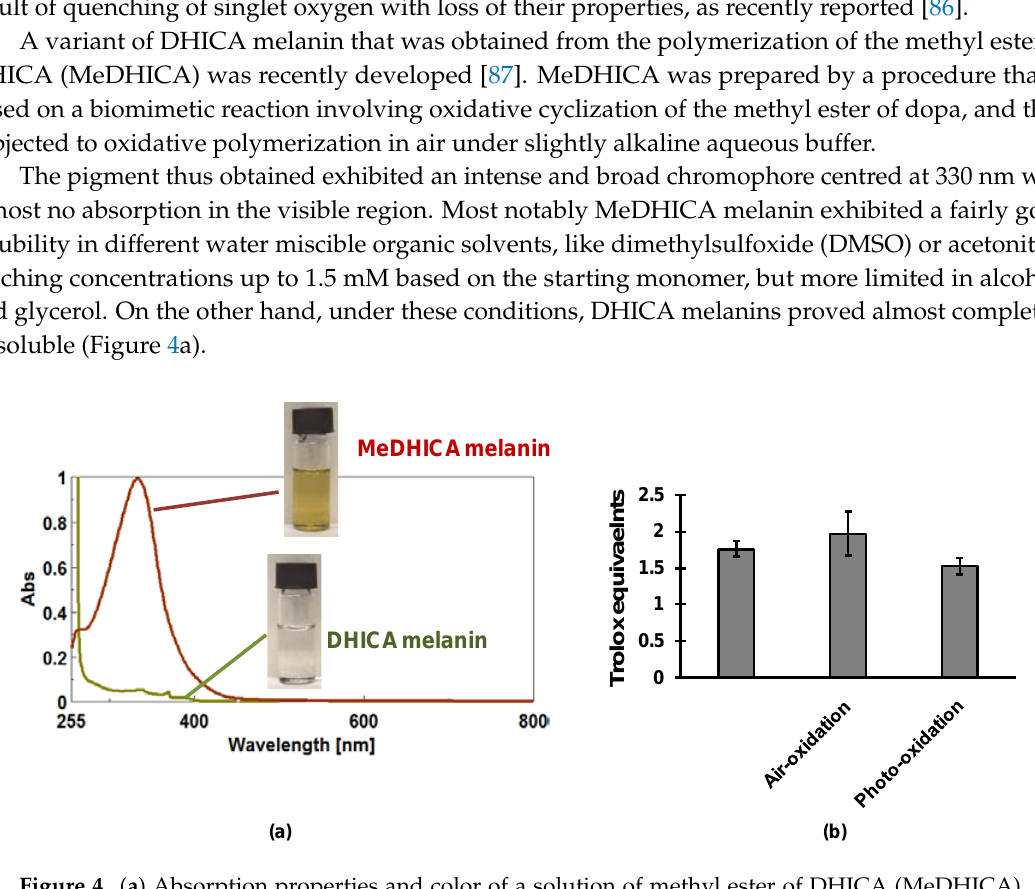
Figure 4. ( a ) Absorption properties and color of a solution of methyl ester of DHICA (MeDHICA) melanin in DMSO. For comparison a suspension of DHICA melanin under the same conditions is shown; ( b ) Ferric reducing antioxidant power (FRAP) assay of MeDHICA melanin before and after exposure to air over one week or photoxidation under solar simulator light for 3 h.